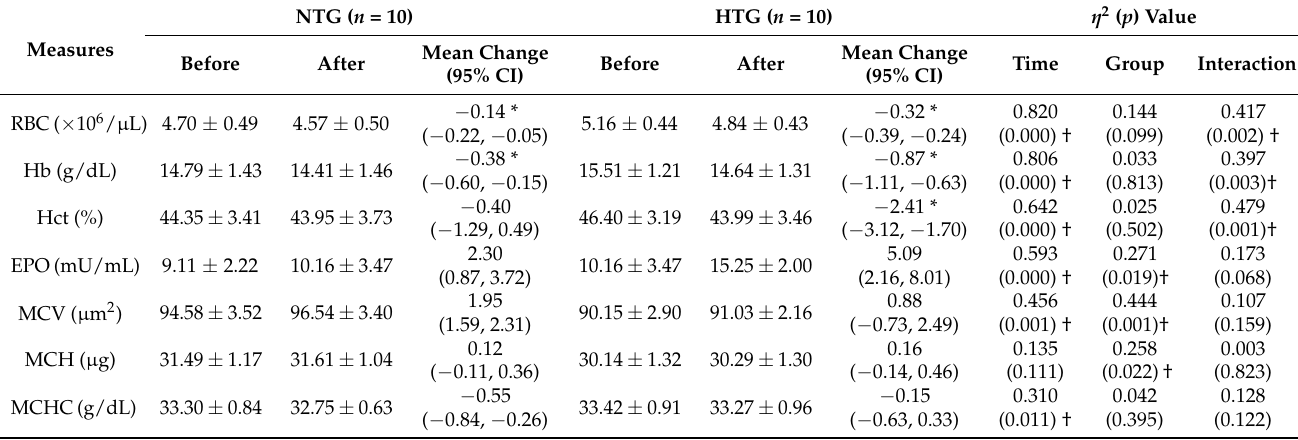
Table 3. Changes in hematological parameters before versus after training by